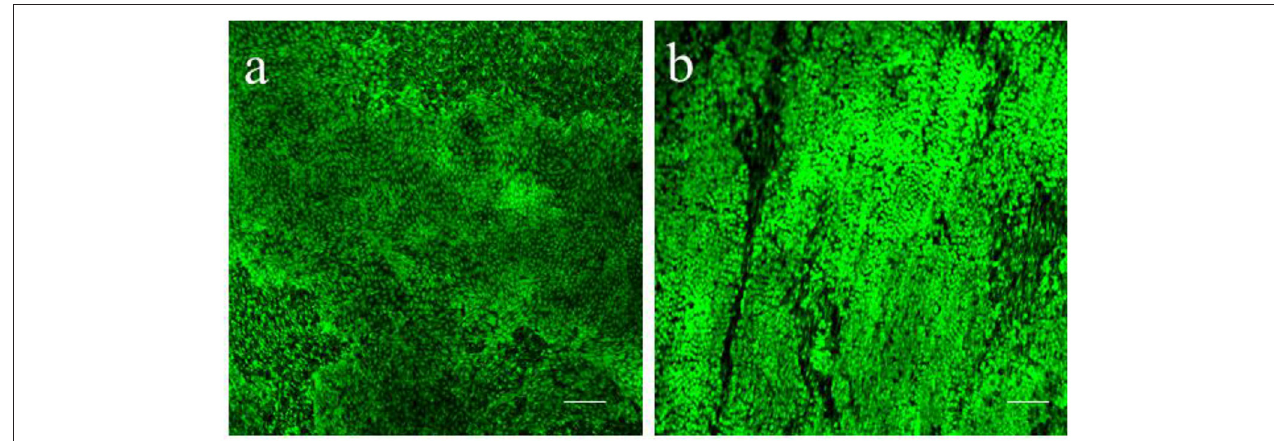
FIGURE 7 | Epicardial slices viability in culture. Calcein AM live staining performed on (a) piglet and (b) adult swine-derived slices, after 72h of culture. Both tissues display large portion of living epicardial cells and the retention of the typical cobblestone morphology. Scale bars, 100 µ m.